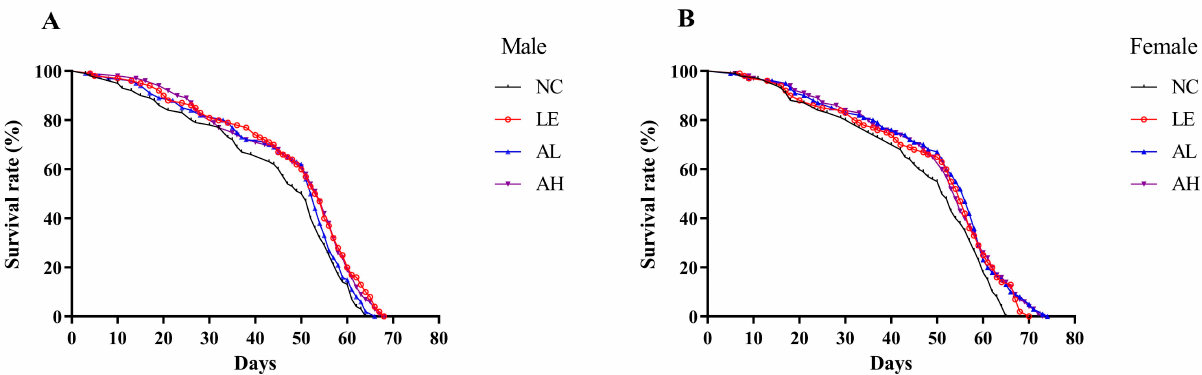
Figure 1. Effects of AAPS on the lifespan of Drosophila melanogaster. ( A ) male and ( B ) female. LE, 3 mg/mL Lentinan; AL, 3 mg/mL AAPS; AH, 9 mg/mL AAPS; ( n = 100 per